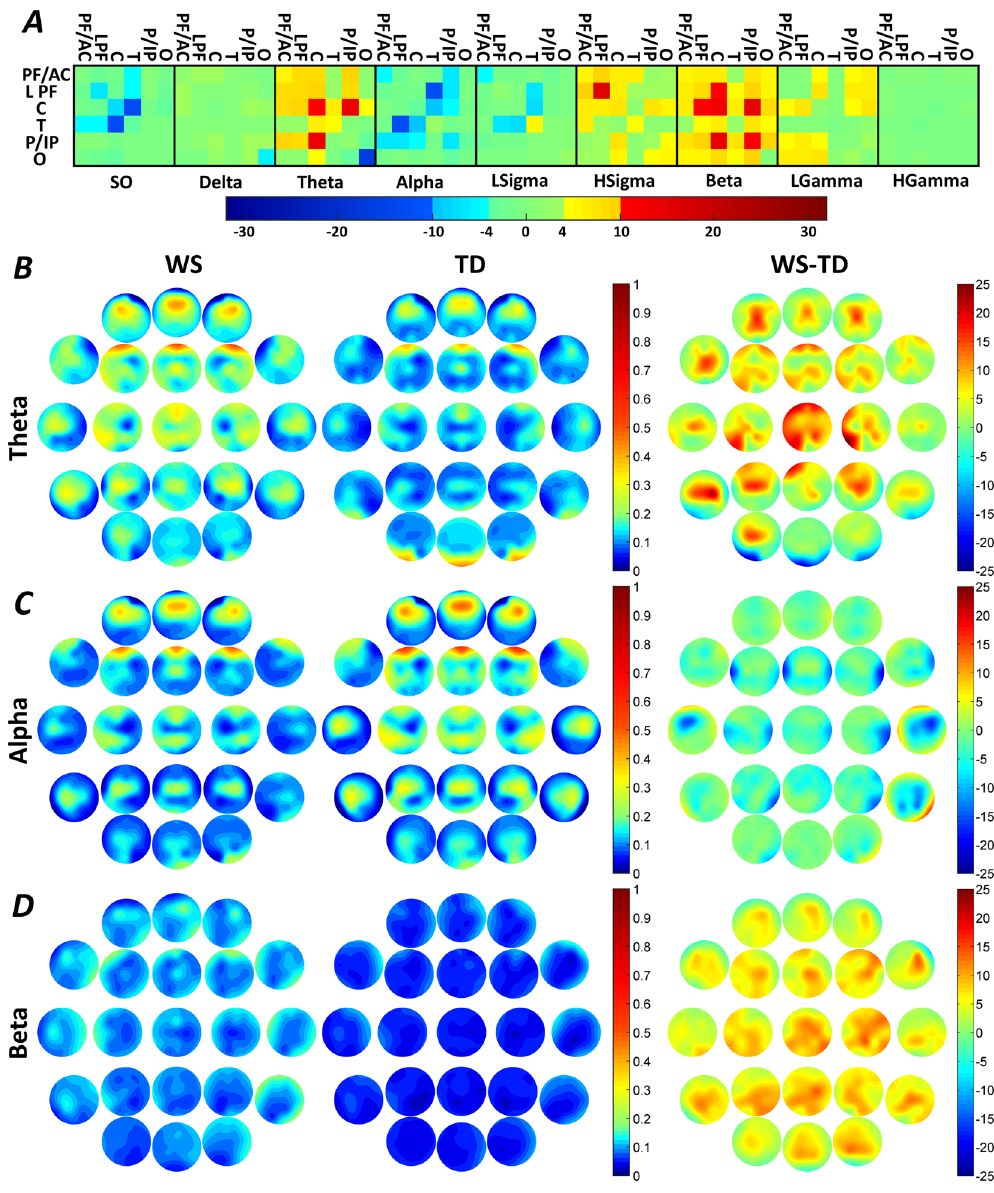
Figure 3. Region-specific and band-limited NREM sleep EEG connectivity differences. Decreased WPLI was evidenced in the slow oscillation range for the C-T inter-regional pairing, as well as in the intra-regional O theta and LPF-T alpha synchronizations. Several Williams syndrome-specific increases in WPLIs were found in the theta, high sigma and beta ranges. Frequency range codes: SO = Slow oscillation, LSigma = Low sigma, HSigma = High sigma, LGamma = Low gamma, HGamma = High gamma. Color codes: Red = Williams syndrome > typically developing (B-H corrected), Yellow-orange = Williams syndrome > typically developing (uncorrected), Green = Williams syndrome ≈ typically developing, Light blue = Williams syndrome < typically developing (uncorrected), Blue = Williams syndrome < typically developing (B-H corrected). B-D. Theta, alpha and beta WPLI maps highlighting the patterns of absolute group means (left: Williams syndrome; middle: typically developing) and Williams syndrome-typically developing differences (right). Positions of the maps represent the seed derivation of the synchronization analyses (according to the 10–20 system), while the color patterns are the representations of the variable strengths in the synchronization (WPLI) between the respective region and the seed